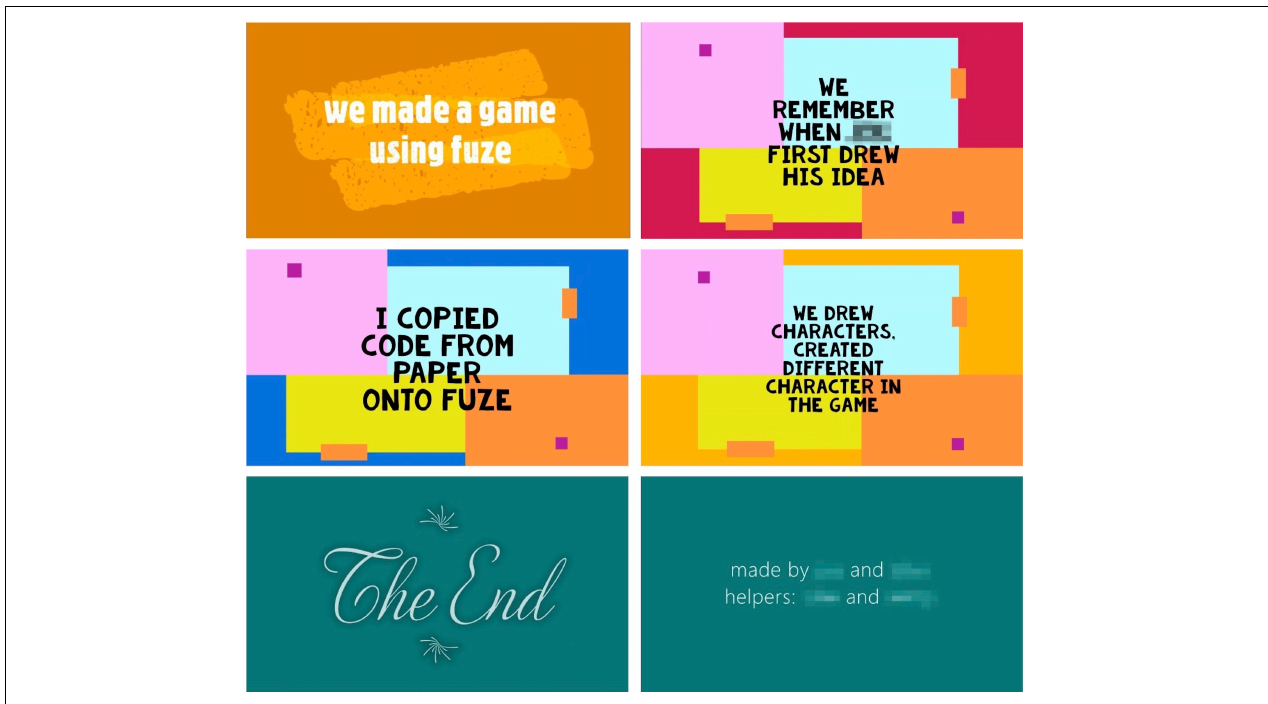
FIGURE 6 | Narrative slides used in Jay and Terry’s Digital Story in shots 1, 3, 5, 7, 9, and 11 (respectively from top left to bottom